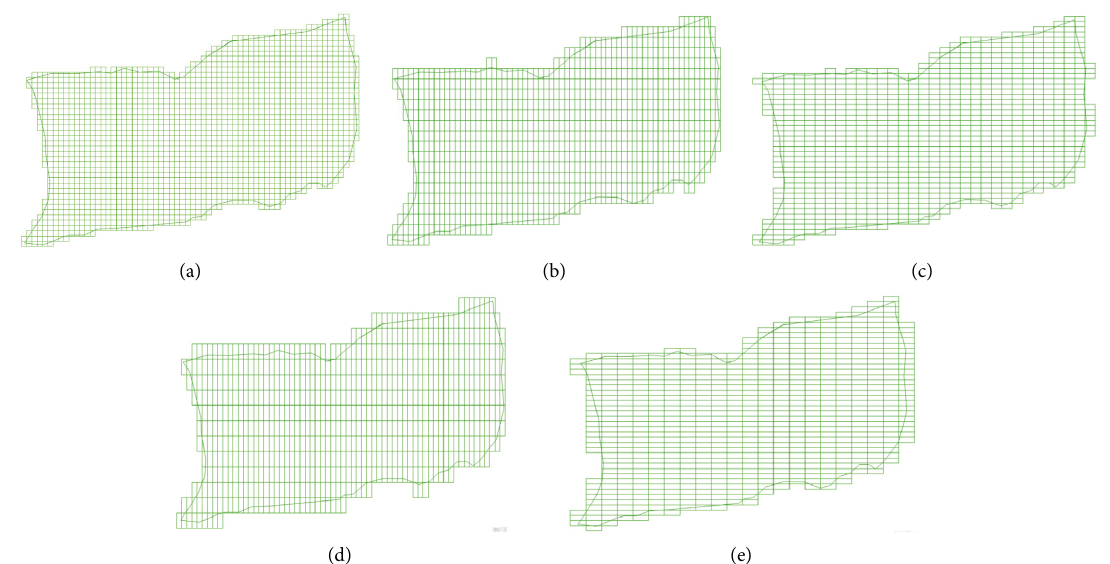
Figure 10: SU types corresponding for a scale of 500m. (a) 500m × 500m. (b) 500m × 1000m. (c) 1000m × 500 m. (d) 500m × 1500m. (e) 1500m ×